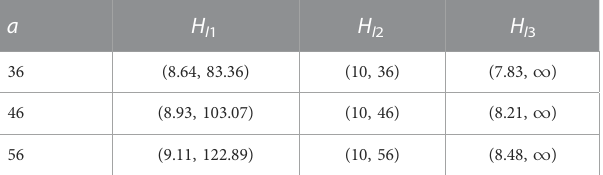
The corresponding characteristic equation is obtained as